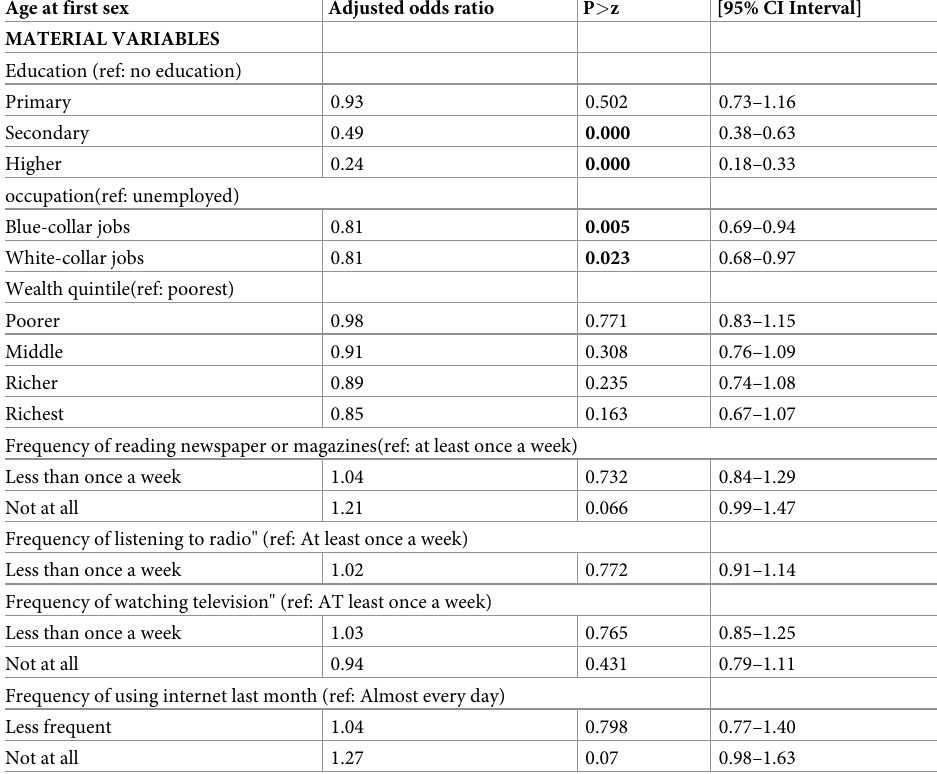
Table 3. Material factors related to early age at first